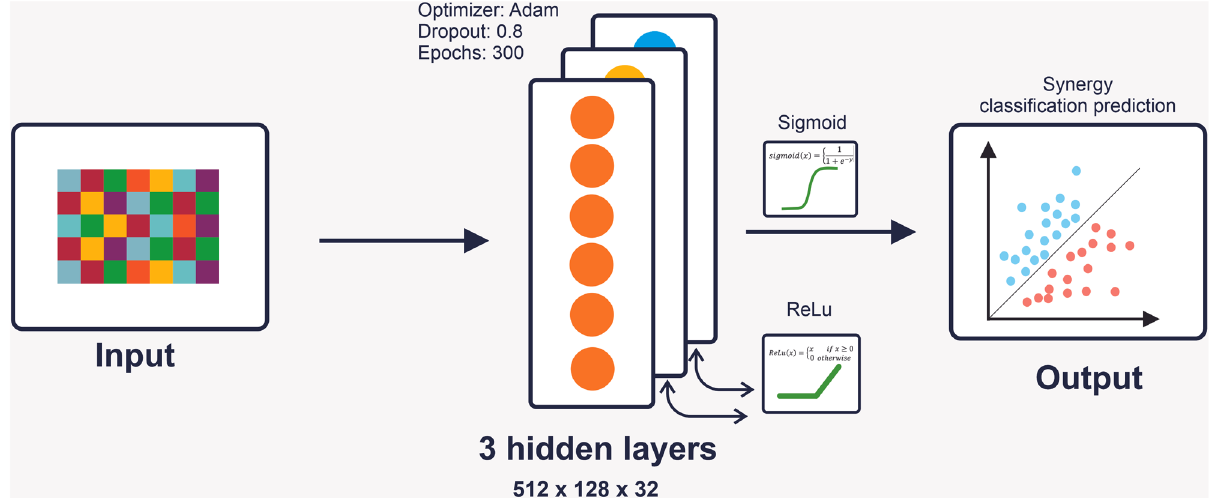
Figure 6. Schematic illustration of the proposed method (SYNDEEP). The model takes the feature vectors as input. The input layer is connected to 3 hidden layers. The number of nodes in each of the three hidden layers was 512, 128, and 32, respectively. Between each of the three hidden layers, there is a ReLu activation function. For the last layer, we adopt a sigmoid activation function. The learning rate was 10 −2